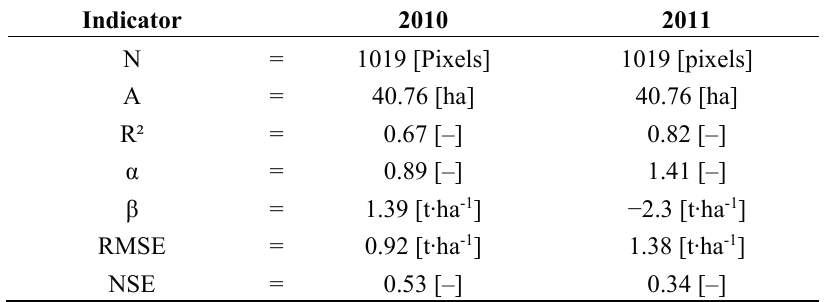
Figure 10. Spatially measured ( a ) and modelled ( b ) yield of winter wheat on test field 33 for the harvesting season of 2011, including an X-Y-plot of the correlation of the two spatial datasets ( c ) as well as the modelled and EO-measured seasonal course of LAI-development for high (yellow pixel) and low (blue pixel) yielding sections of the field ( d ). A quantitative comparison is given in Table 7. Table 7. Validation statistics for field 33 (2010 vs . 2011). Also compare Figures 9 and